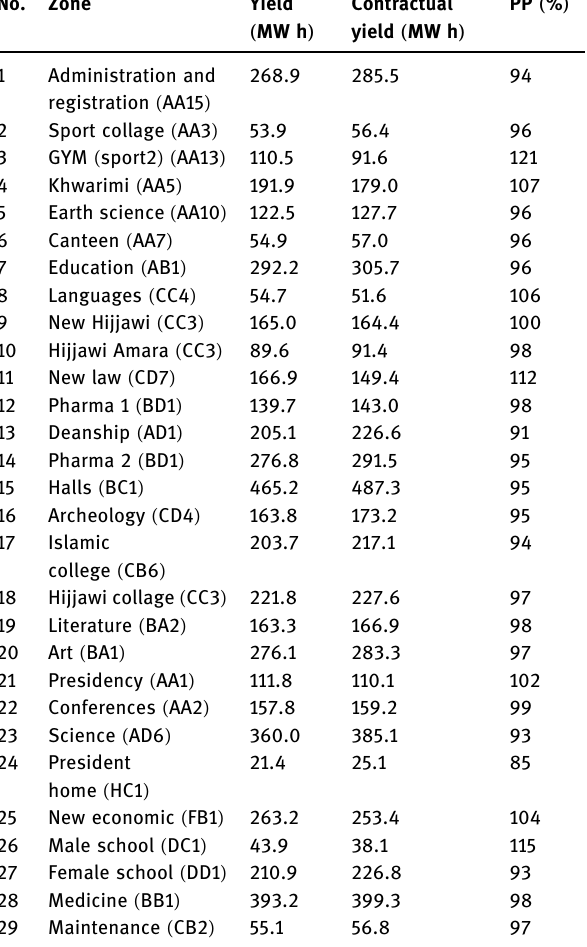
Table 4: Actual yield, contractual yield, and PR for Yarmouk University PV solar power plant during the third operational year ( 2019 ) , which are re fl ected in all zones generation [ 14 ]